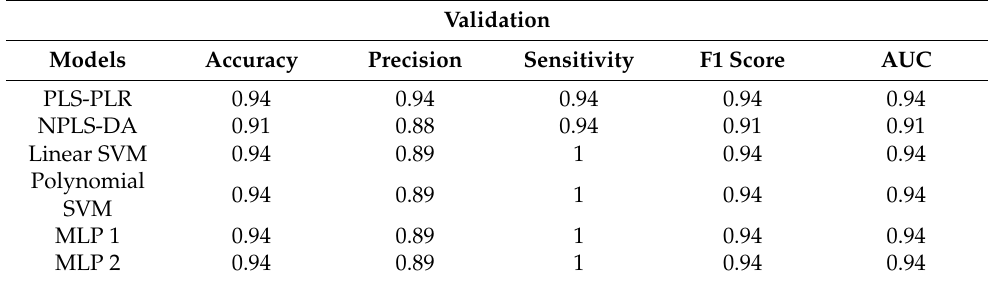
Table 3. Comparative table of models evaluation metrics in the validation phase.